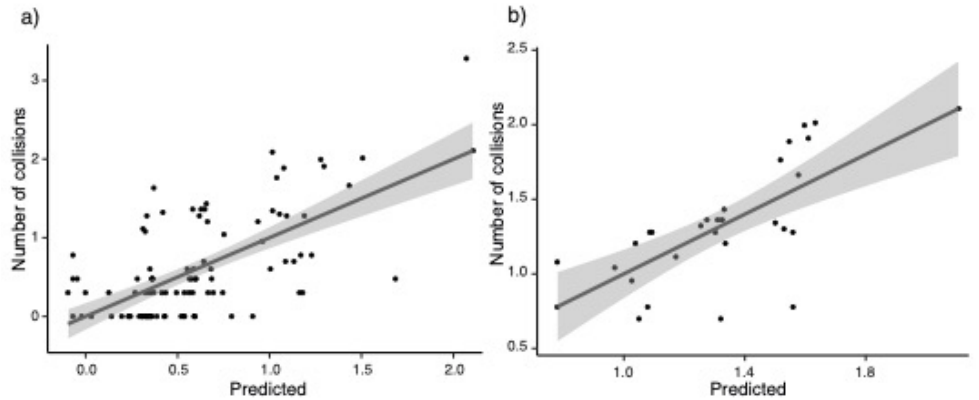
Figure 2. Estimated values (log10) for the number of collisions predicted by the formulas ( x -axis) and real values ( y -axis) for all species included in the model (( a ); R 2 = 0.43) and the reduced dataset of 29 species (( b ); R 2 = 0.52). Regression line and 95% confidence intervals are shown with a dark line and grey shadow. Baseline levels for each factor (High-speed for the “Flight type” predictor and Sedentary for the “Movements” predictor) have a coefficient of 0.